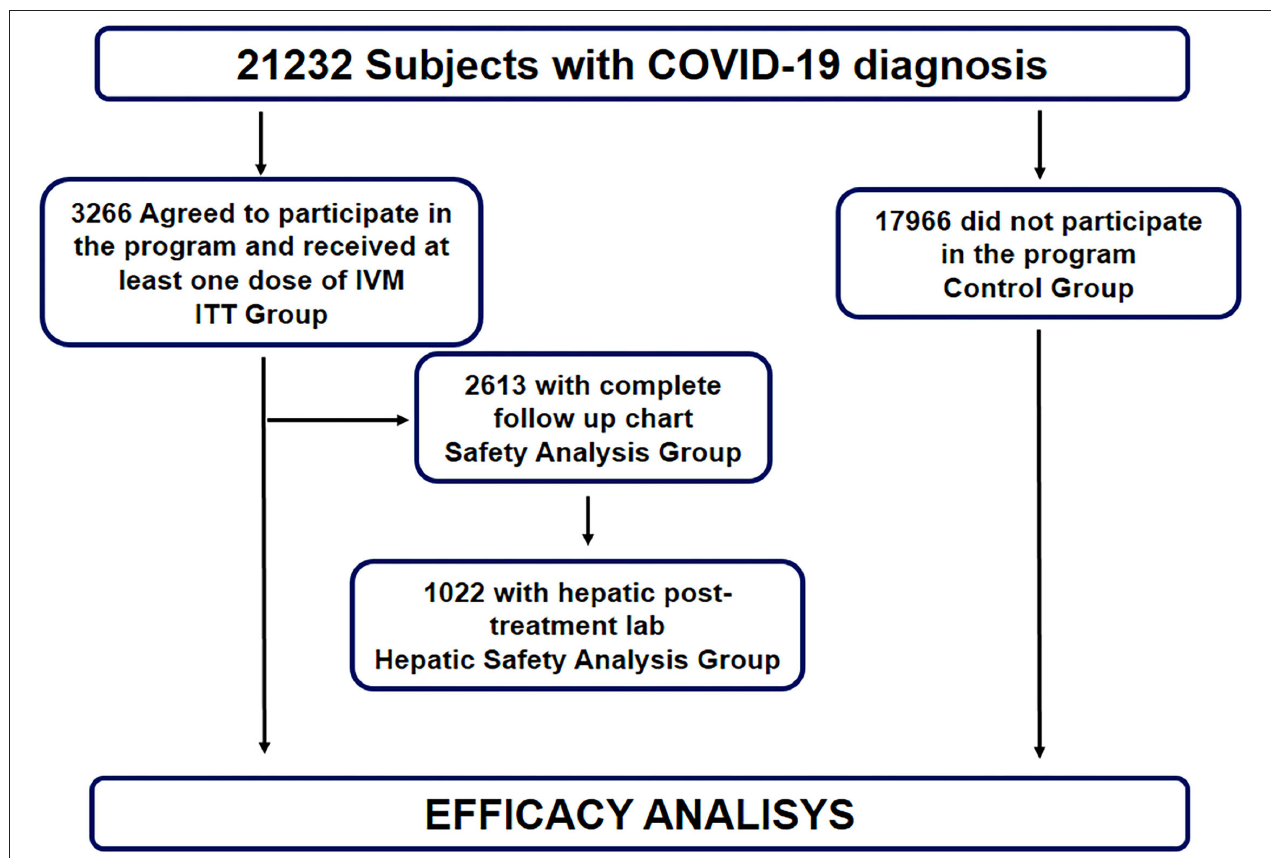
FIGURE 1 | Flow diagram of the MEURI program for the use of high dose IVM in ambulatory COVID-19 patients.